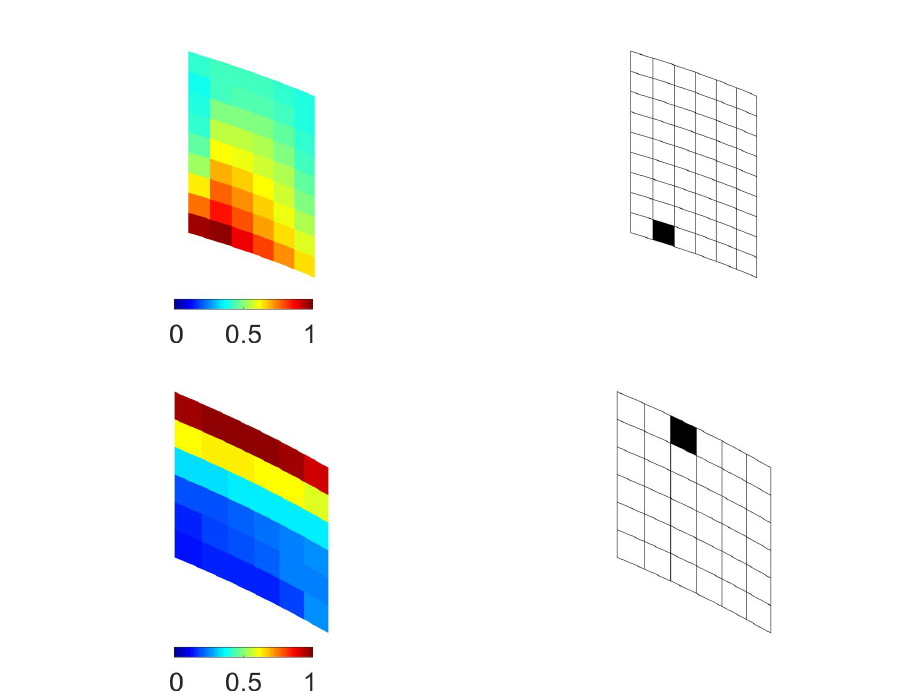
Figure 9. Stiffened fuselage section problem, Case (1), mesoscale analysis: ( left ) contour plots of the local objective function ψ m , and ( right ) relevant optimal sensor placement with N m = 1; results reported for ( top ) i = 69 and ( bottom ) i = 100.